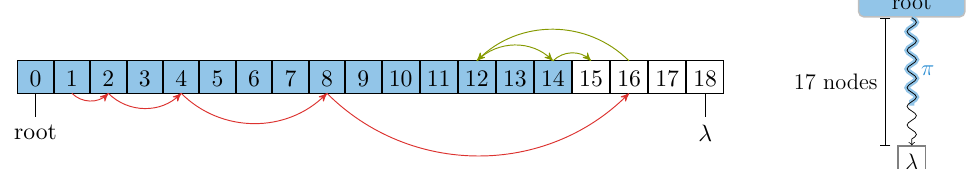
Figure 6. Exponential search on a root-to-leaf path for the first node that does not meet a specific condition. In the setting of the non-overlapping LZSS factorization of Section 4 as well as in the LZ78 factorization of Section 4.5, the path from the root to a leaf λ contains a sub-path π including the root whose contained nodes all share a common property (for LZSS they meet the condition on Line 10 of Algorithm 1, while for LZ78 they are edge witnesses marked in the bit vector B E ). We symbolize the path from the root to λ as an array, where each node is represented by its depth. The sub-path π is visualized by the shaded entries